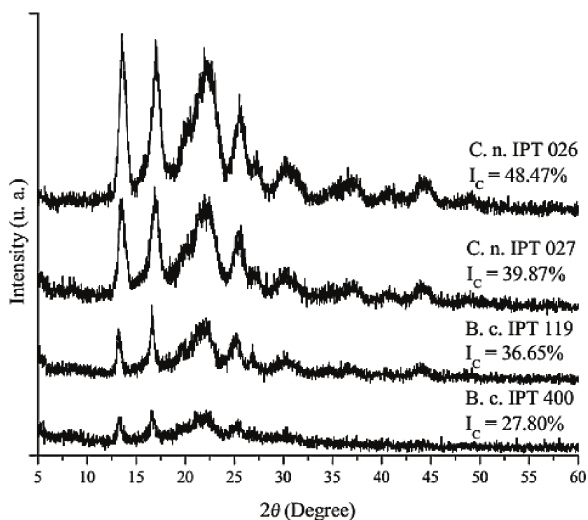
Fig. 3 – X-ray diffractograms of PHA produced by C. neca- tor and B. cepacia strains in submerged cultivation with crude palm